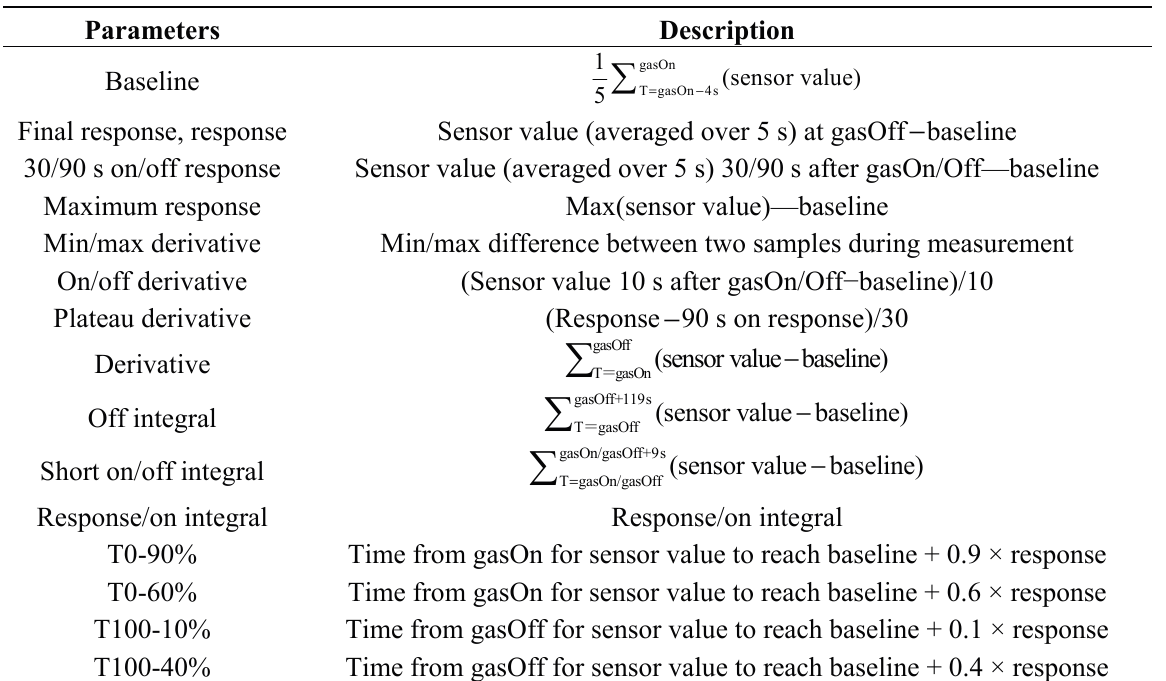
Table 3. Description of features extracted from original response curves in